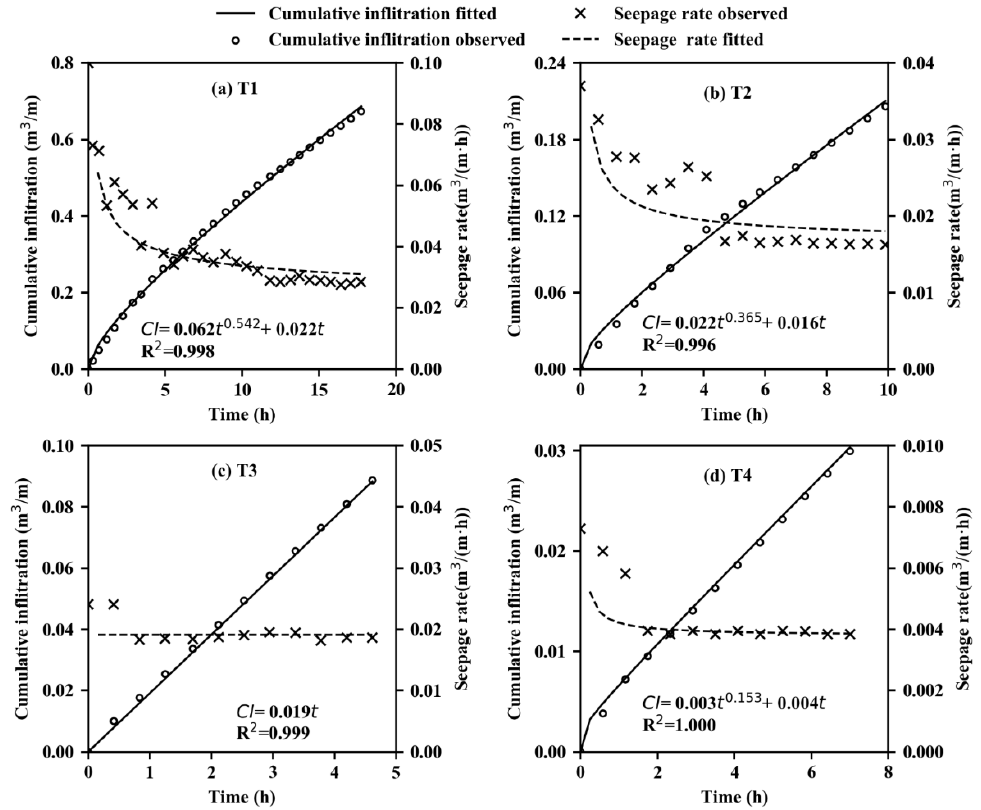
Figure 5. The cumulative infiltration and seepage rate per meter of canal for the four treatments: ( a ) T1; ( b ) T2; ( c ) T3; and ( d ) T4. Note: The canal lining of T1, T2, T3, and T4 treatment was geomembrane and concrete with a three year service time, geomembrane with a three year service time, no lining, and new precast concrete slabs and new geomembrane.